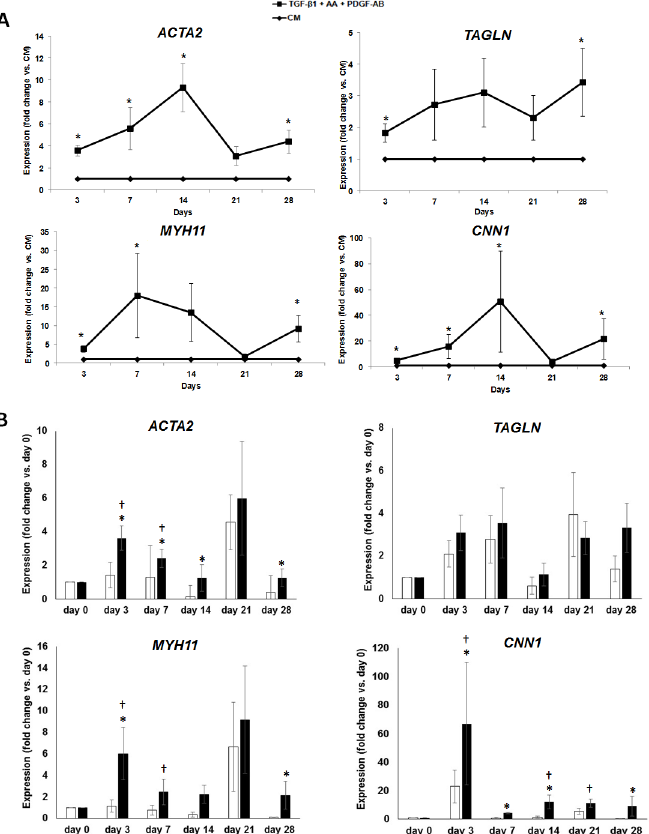
Fig 1. Expression levels of contractile SMC-specific genes. MSCs were expanded in GMP expansion medium until they were 70% confluent and at passage 2 treated with control medium (CM) or SMC differentiation medium (5 ng/mL human TGF- β 1, 5 ng/mL human PDGF-AB and 30 μ M ascorbic acid) for 0, 3, 7, 14, 21 and 28 days. Differentiation was analyzed by qRT-PCR. Transcript levels were calculated relative to GAPDH and PPIA . (A) Data was calculated relative to CM for that time point. * p < 0.05 compared to CM at the respective day of differentiation. (B) Data was calculated relative to day 0, the starting point of differentiation. * p < 0.05 compared to CM at the respective day of differentiation; † p < 0.05 compared to day 0. n = 6 – 8. Error bars indicate SEM.